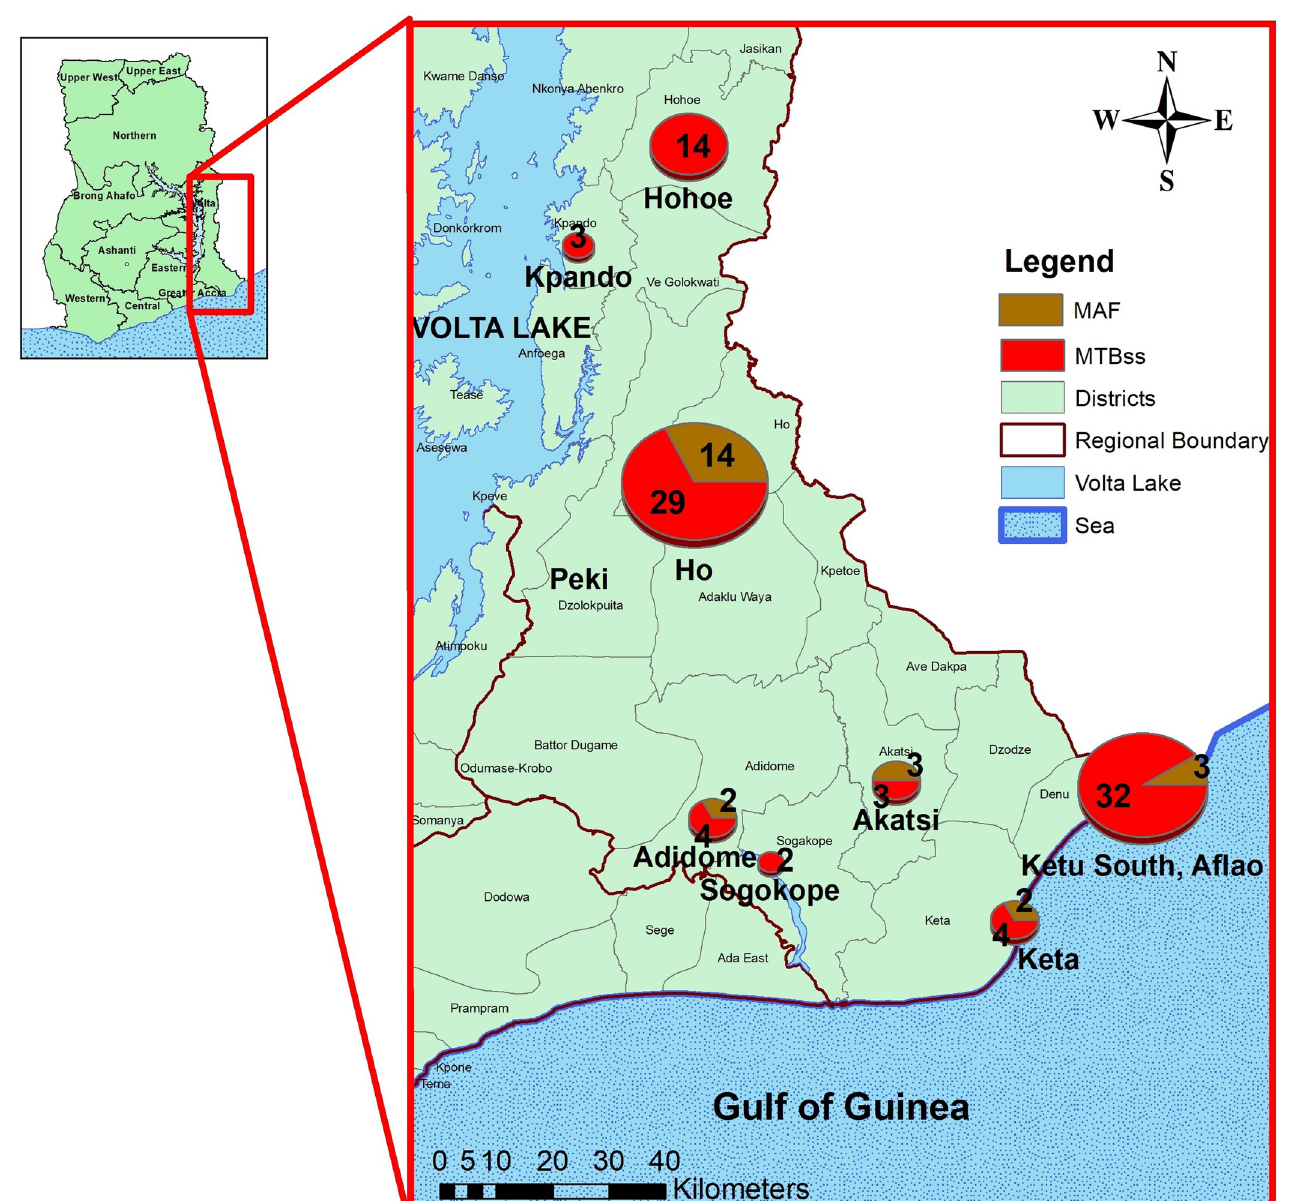
Fig 3. Geospatial distribution of the two human adapted MTBC species; M . tuberculosis sensu stricto (MTBss) and M . africanum (MAF). Figure was generated in ArcGIS. Permissions : The authors permits unrestricted use, distribution, and reproduction in any medium, provided the original author and source are